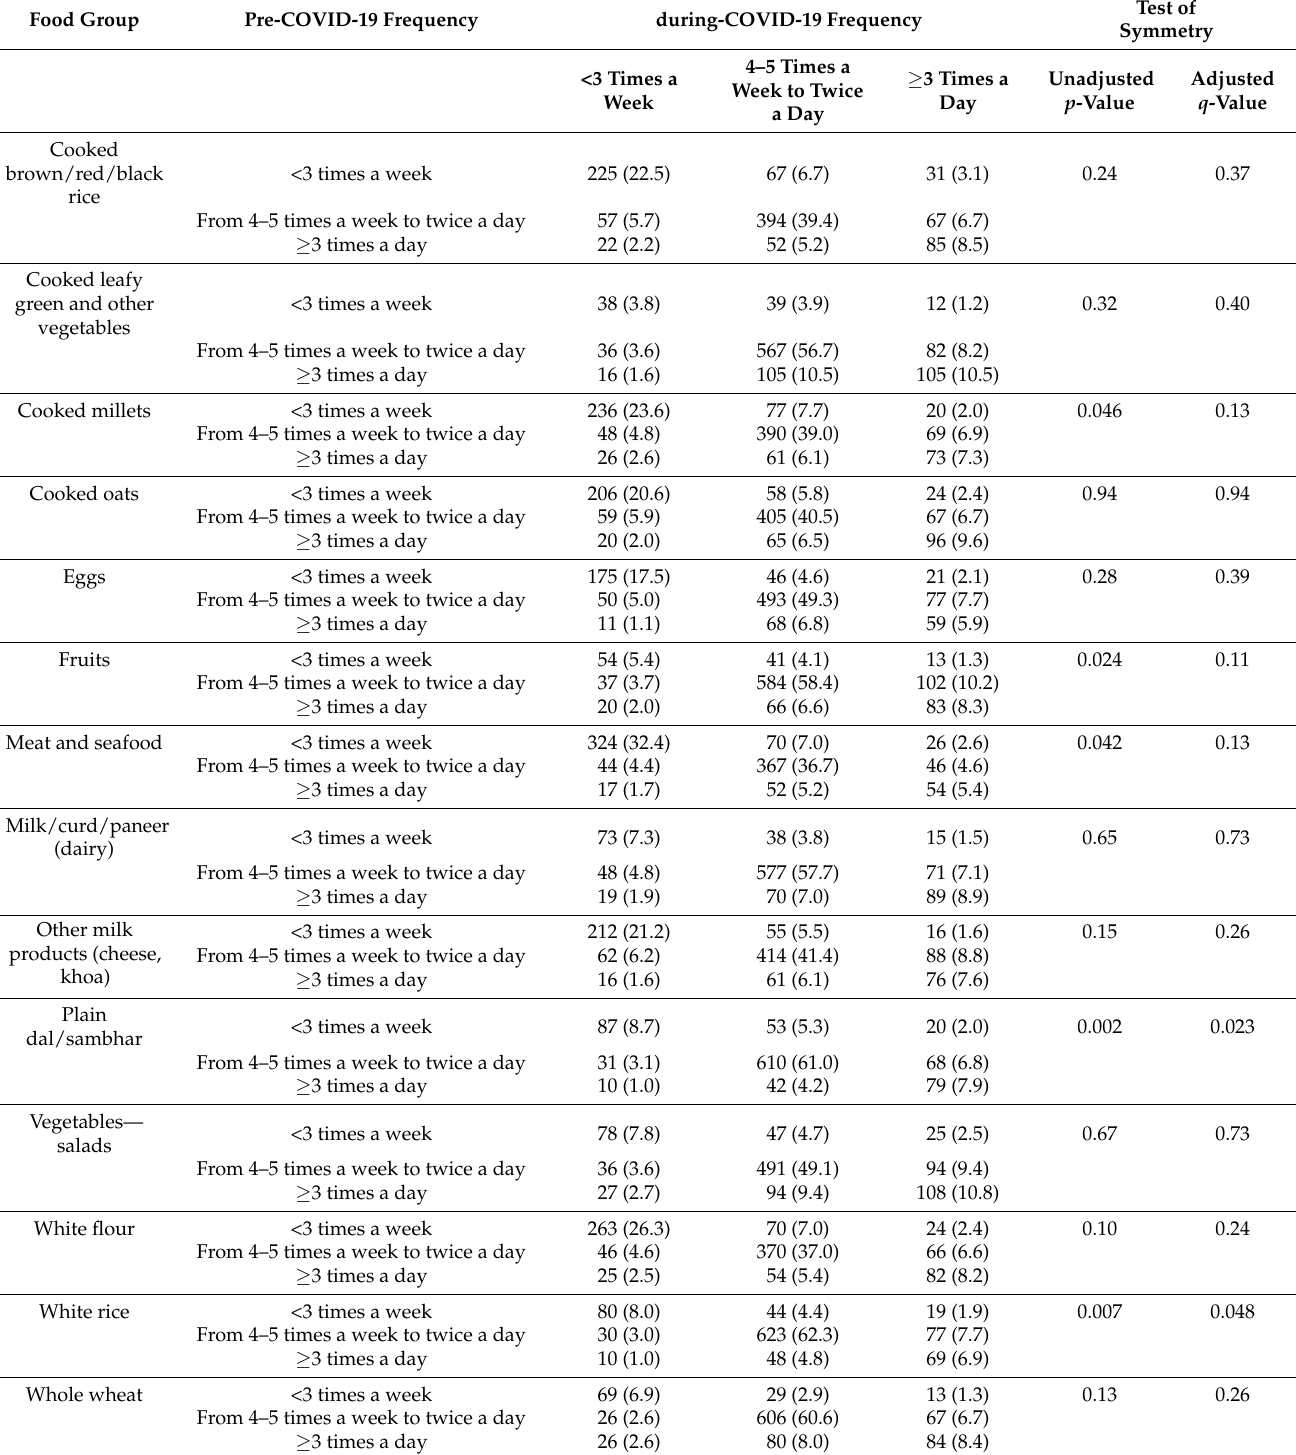
Table 2. The change in self-reported intake frequency of 14 food groups during the COVID-19 confinement compared to pre-COVID-19